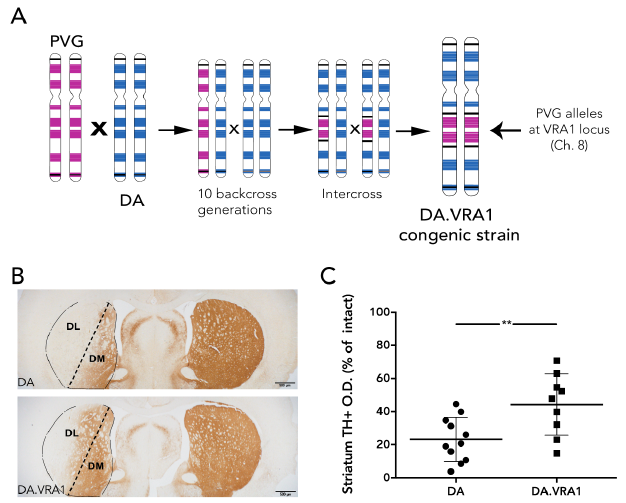
Figure 1. The Vra1 locus confers protection of striatal dopaminergic fibers after 6-OHDA lesion. ( A ) Breeding schematic for the DA.VRA1 congenic strain: PVG.1AV1 was back-crossed to DA 10 times with selection on the Vra1 region; an intercross generated the homozygous DA.VRA1 congenic strain, with >99.9% DA genome outside of the congenic fragment. ( B ) Representative pictures showing coronal sections of the striatum from each strain stained for Tyrosine Hydroxylase (TH). Scale bar = 500 µ m The lesioned striatum is divided in two parts: DL, the region receiving most afferent projections from the cells of the substantia nigra pars compacta, and DM. ( C ) Optical density (O.D.) quantification of TH+ fibers in the lesioned DL relative to the intact DL striatum at 8 weeks post-surgery. DA.VRA1 rats display a higher density of TH+ fibers in the lesioned relative to intact DL striatum, suggesting increased dopaminergic fiber survival compared to DA. Mean ± SD, ** p < 0.01 after an unpaired t -test. (DA = Dark Agouti; DA.VRA1 = Vra1 congenic; DL = Dorsolateral; DM = Dorsomedial)